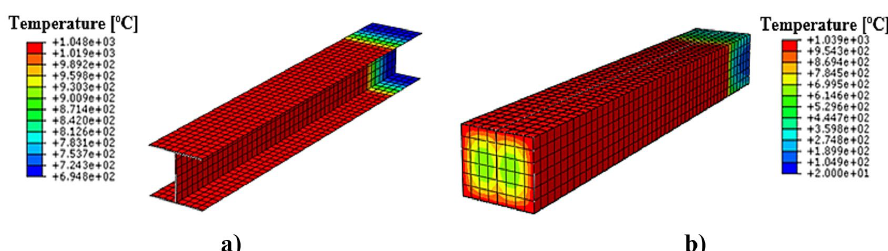
Figure 5. Thermal field for the columns: (a) H220-ISO e (b) H220-CONC-ISO.